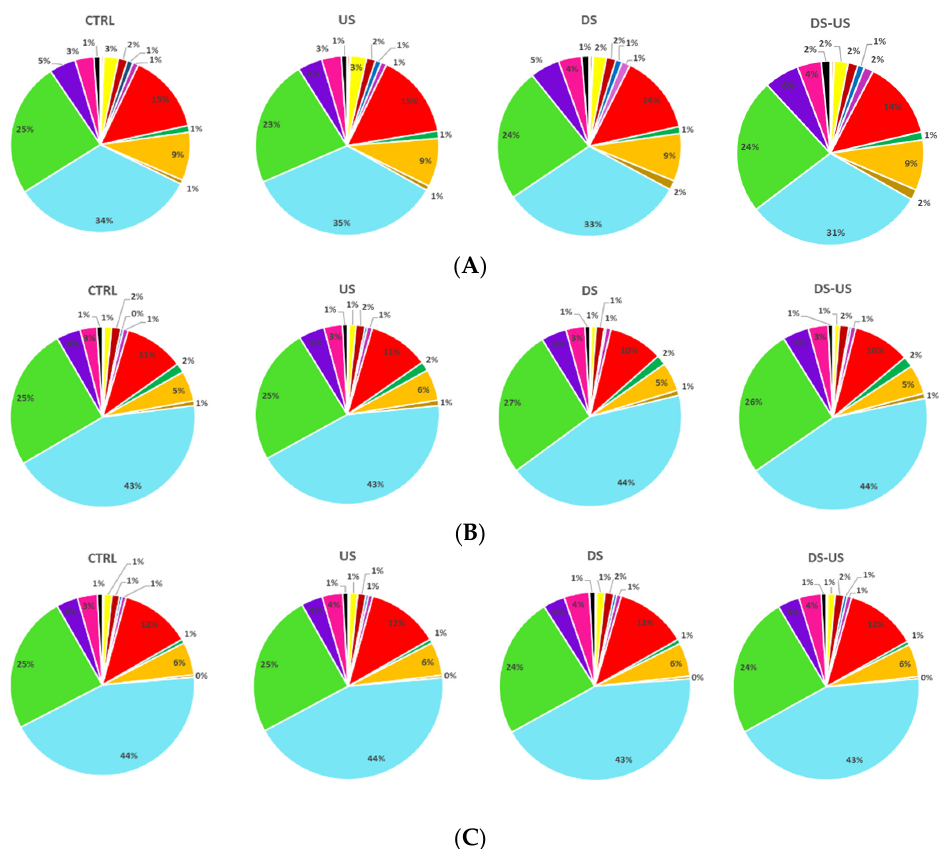
Figure 3. Triglyceride composition (%) of Peranzana ( A ), Canino ( B ), and Coratina ( C ) EVOOs, treated by the different processes (CTRL = control test, US = ultrasound test, DS = destoned test, DS-US = destoned-ultrasound test). LLL = trilinolein-glycerols, PLLn = palmitoyl-dilinoleoyl-glycerols, OLLn = linolenoyl-oleoyl-linoleoyl-glycerols, PLLn = dilinoleoyl-palmitoleoyl-glycerols, PoLL = dilinoleoyl-palmitoleoyl-glycerol, OOLn = dioleoyl-linolenoyl-glycerols, PoOL = palmitoleoyl-oleoyl-linoleoyl-glycerol, PoPoO = dipalmitoleoyl-oleoyl-glycerol, PPoPo = dipalmitoleoyl-palmitoyl- glycerol, PPoL = palmitoyl-palmitoleoyl-linoleoyl-glycerol, LnPP = dipalmitoyl-linoleoyl-glicerol, PLO = palmitoyl- linoleoyl-oleoyl-glycerol, POO = dioleoyl-palmitoyl-glycerol, OOO = triolein-glycerols, SLL = dilinoleoyl-stearoyl- glycerol, PoOO = dioleoyl-palmitoleoyl-glycerol, SPoL = stearoyl-palmitoleoyl-linoleoyl-glycerol, POP = dipalmitoyl- oleoyl-glycerol, PoOP = palmitoyl-palmitoleoyl-oleoyl-glycerol, SOLn = stearoyl-oleoyl-linoleoyl-glycerols, SOO = dioleoyl-stearoyl-glycerol, POS = palmitoyl-oleoyl-stearoyl-glycerol, SPoL = stearoyl-palmitoleoyl-glycerol, SLS = distearoyl-linoleoyl-glycerols. The main triglycerides found were OOL + LnPP, PLP + OOO + PoPP, SOL + POO and POP (12.3 ± 1.9%, 40.0 ± 5.2%, 24.6 ± 1.0% and 4.4 ± 0.8%, respectively). The cultivar with the highest content of OOL + LnPP and POP was Peranzana (mean value across the processes: 14.4 ± 0.8%, 33.1 ± 1.6%, 23.8 ± 0.8% and 5.10 ± 0.7%, respectively), whereas for the lowest value was Canino for OOL + LnPP (10.2 ± 0.5%) and Coratina for POP (3.7 ± 0.8%). Similar high values of PLP + OOO + PoPP were found in Canino and Coratina CV (43.5 ± 0.3%), while a significantly low level was found in Peranzana (33.1 ± 1.6%). Moreover, this latter cultivar showed the lowest SOL + POO content (23.8 ± 0.7%) compared to Coratina (28.4 ± 0.3%). As reported by several authors [33–35], the triglyceride profile showed a high variability in relation to the investigated cultivars and could be useful to classify and characterize monovarietal oils [25]. The extraction process significantly affected triglyceride composition, but with a minor influence with respect to the cultivars. In detail, the main variation on triglycerides profiles were observed when DS was applied, however, highlighting a different effect in relation to the considered cultivars. Our results are in agreement with López-López et al.